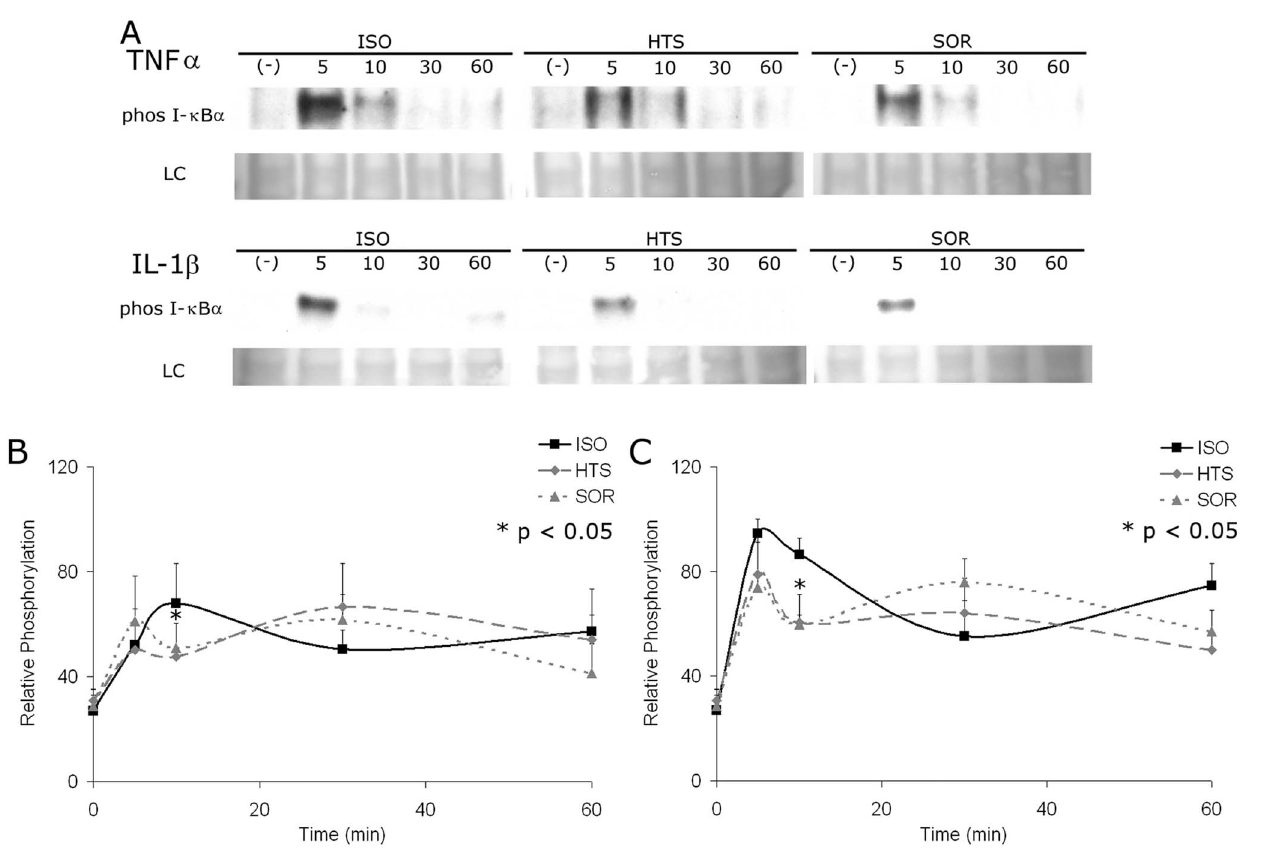
Figure 5. HOsm inhibits phosphorylation of I- k B a induced by both TNF a and IL-1 b . Phosphorylation of I- k B a is inhibited at 10 minutes in cells stimulated with TNF a or IL-1 b (10 ng/ml) by either 400 mOsm HTS or SOR treatment. The immunoblot is representative of five separate experiments. LC represent the loading control obtained by Ponceau-S stain of the nitro cellulose membranes. Phosphoprotein ELISA time course of cells stimulated by TNF a (B) or IL-1 b (C) (both 10 ng/ml), in the presence of 400 mOsm HTS or Sorbitol; normalized for phosphoprotein/total protein levels. Phosphorylation of I- k B a initially diminished with either TNF a (B) or IL-1 b (C) stimulation when treated with HOsm; however, I- k B a phosphorylation increases at 30 minutes with HOsm over isotonic treatment with either stimulus; * p , 0.05 for ISO vs. either HTS or SOR at matched time points; no significant differences were found between HTS and SOR